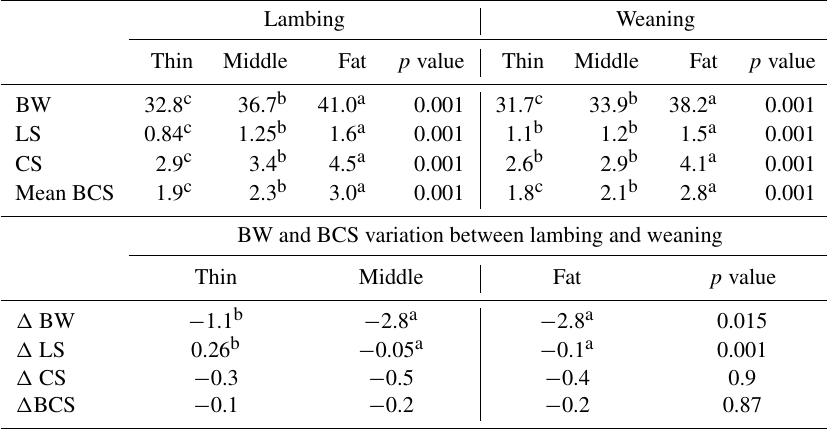
Mean BCS: mean between LS and CS; (cid:49) BW: the variation in BW between lambing and weaning; (cid:49) LS: the variation in LS between lambing and weaning; (cid:49) CS: the variation in CS between lambing and weaning. Different superscripts